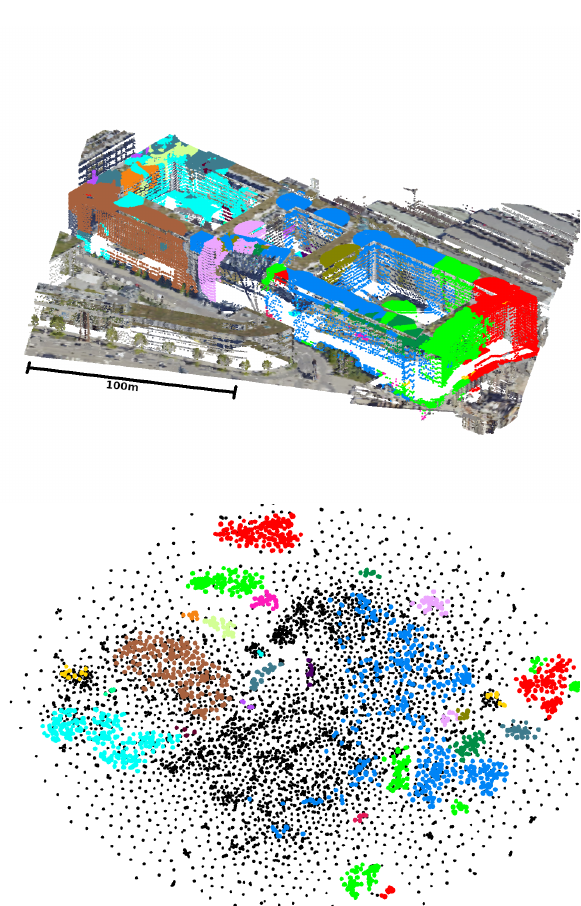
Figure 8. Top: ALS point cloud with colored clusters on Building A. Bottom: Corresponding t-SNE embedding. The related time series are given in Figure 9.